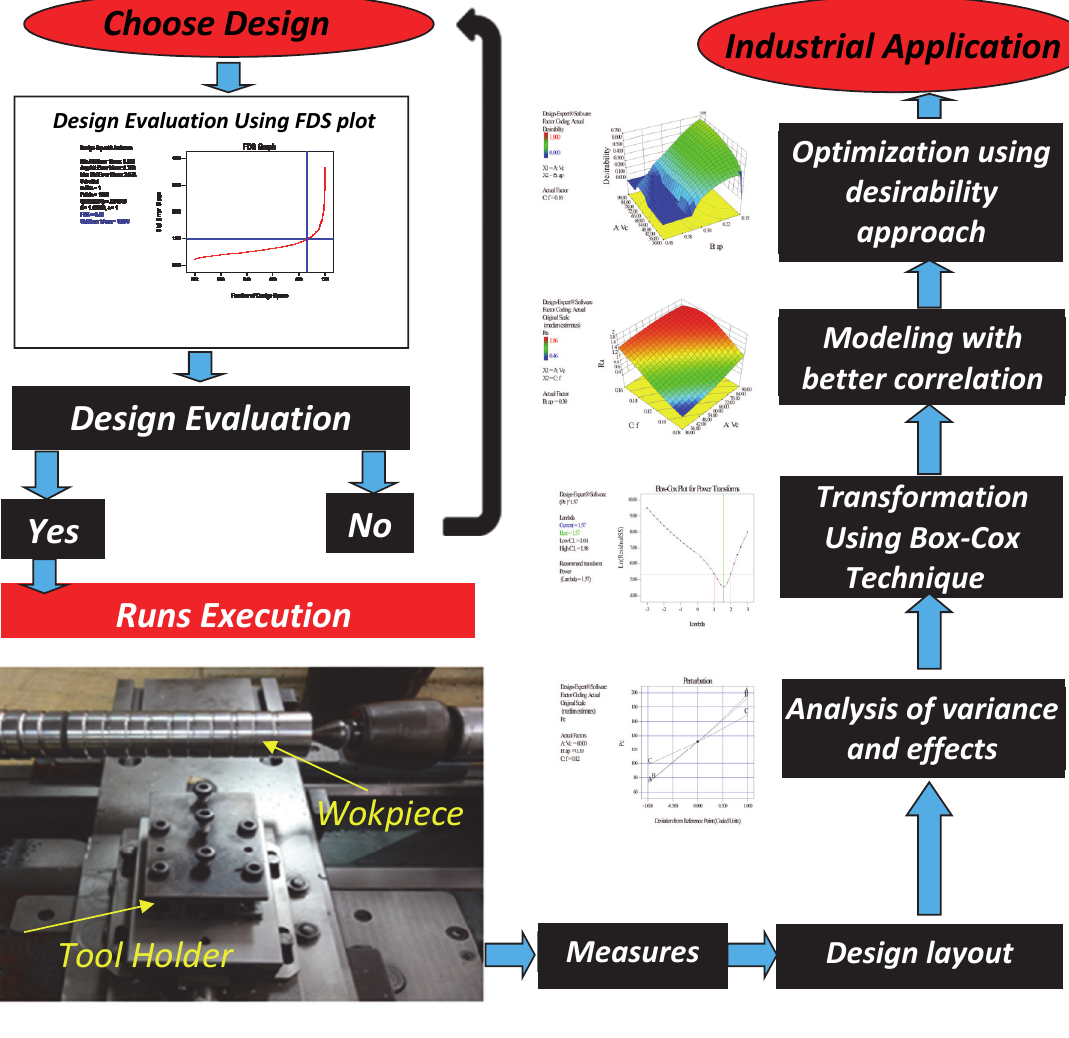
Fig. 1. Set-up and design of experiments